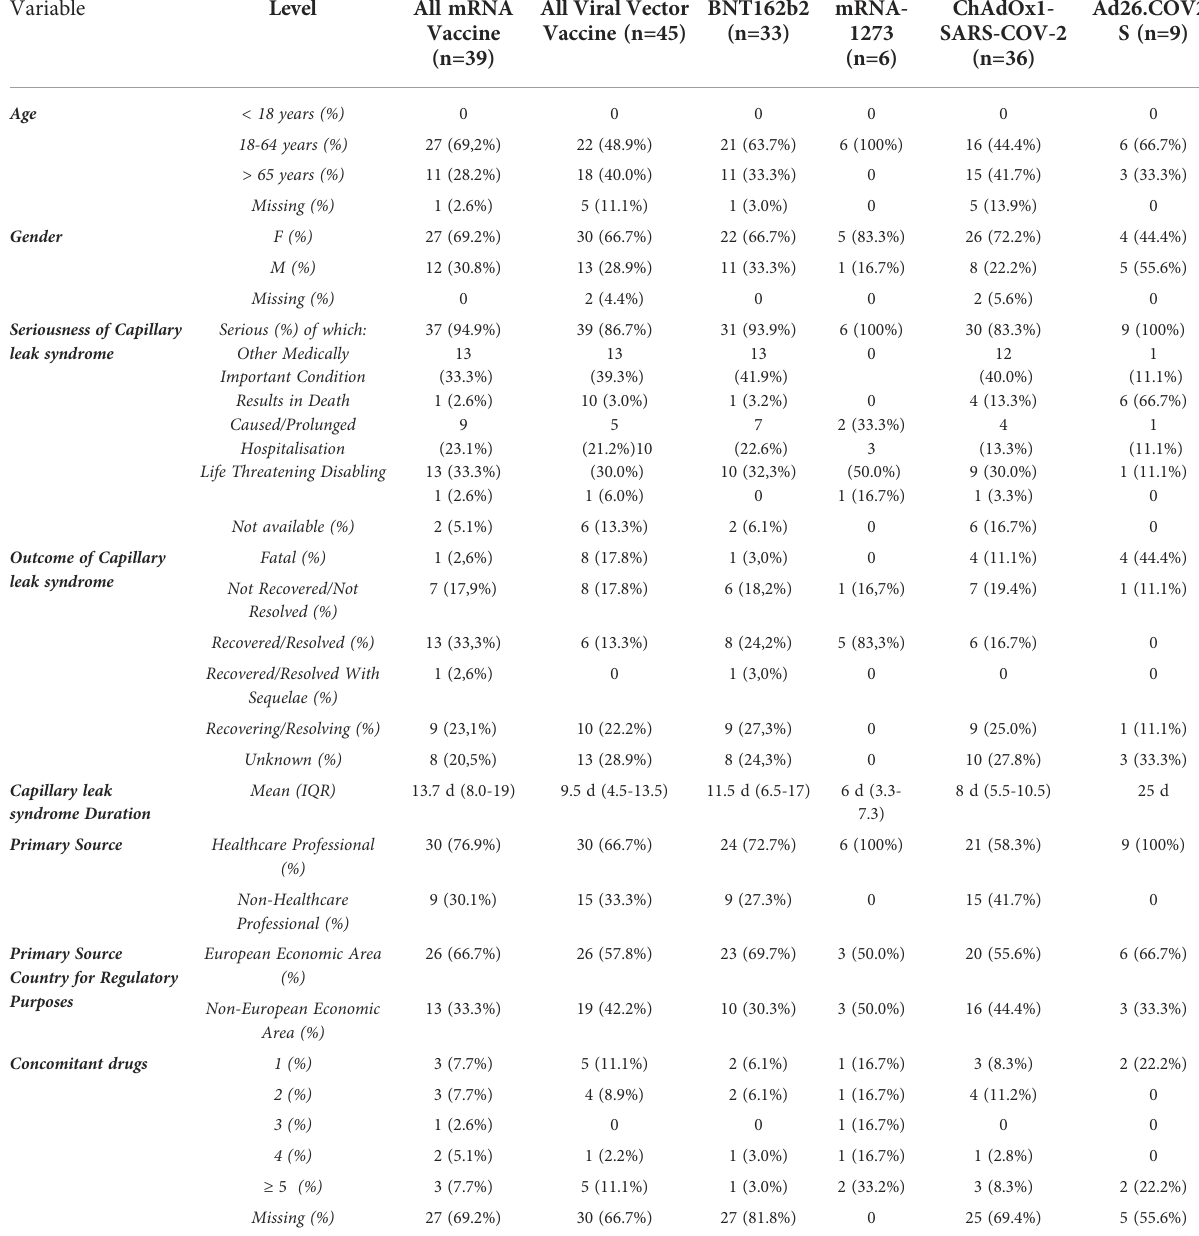
TABLE 1 Demographic characteristics of Individual Case Safety Reports (ICSRs) involving COVID19 vaccines reported in the EudraVigilance spontaneous reporting system from 1st January 2021 to 14 th January